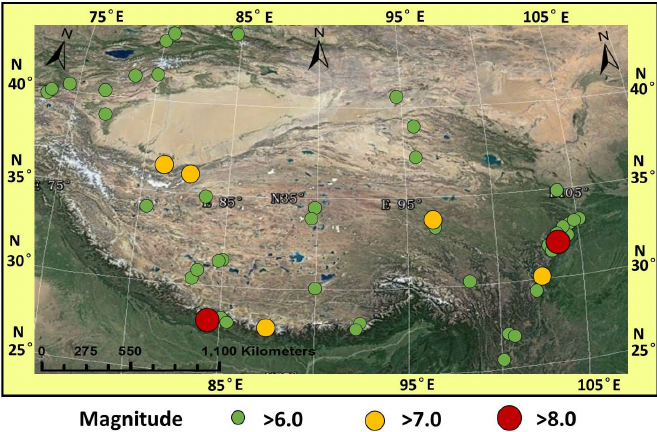
Figure 2. Distribution of the earthquake events in the Qinghai-Tibet Plateau from 2003 to 2015.